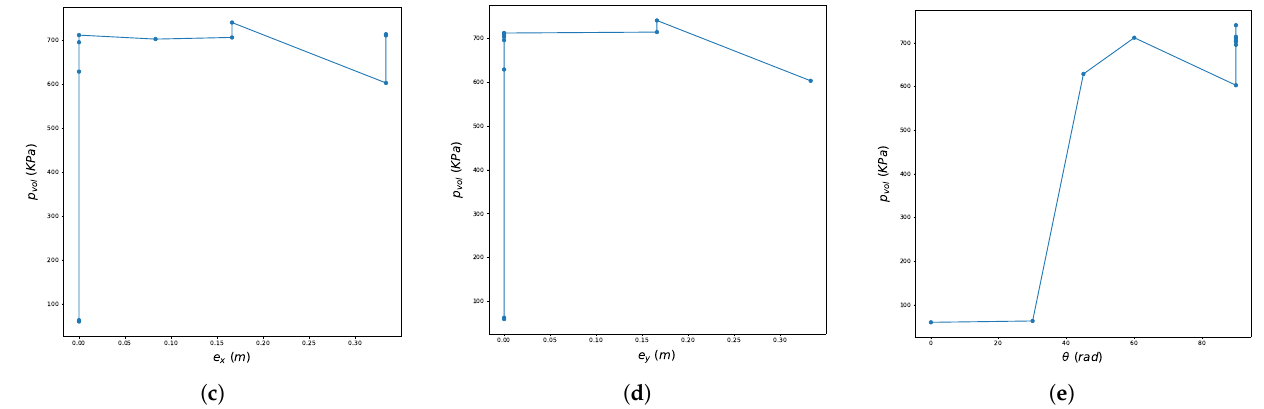
Figure 11. Graphical presentation of the Neural Network that corresponds to Monte Carlo analysis S - κ L - c R -d3 (NND3) for the estimation of the volumetric component of the stress p vol in kPa. ( a ) 3D representation of the Neural Network. ( b ) Epochs-Loss diagram. ( c ) Neural Network representation in the projection of the input axis of e x . ( d ) Neural Network representation in the projection of the input axis of e y . ( e ) Neural Network representation in the projection of the input axis of θ .